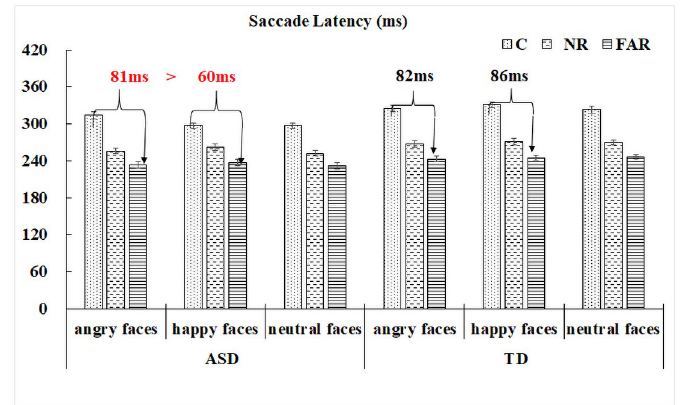
Fig 4. Saccade latency results for each distractor position condition for all distractor types and groups, showing an interaction among three factors in which greater RDE effect amplitude between C and FAR conditions in angry versus happy face distractor condition was observed in the ASD group, but not in the TD